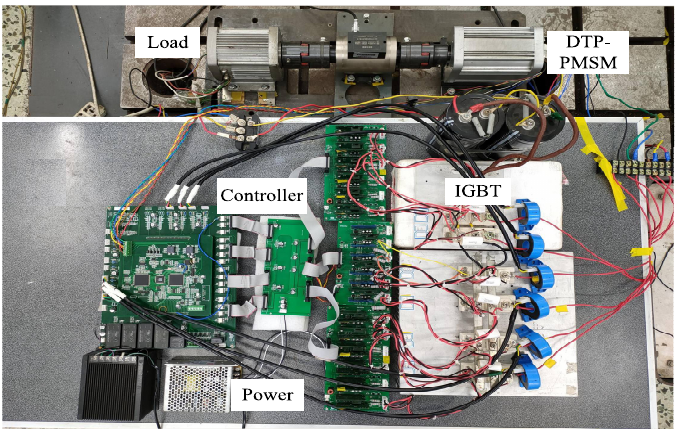
Figure 15. DTP-PMSM experimental platform.